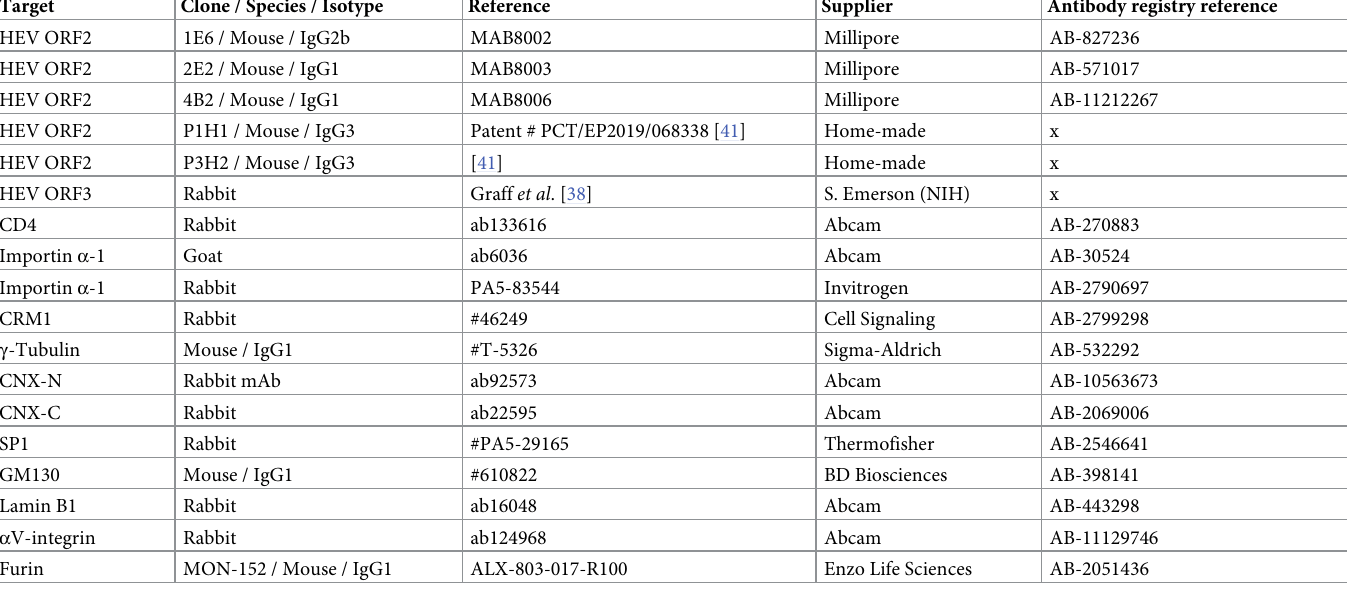
Table 1. Primary antibodies used for Western-blot, immunoprecipitation and indirect immunofluorescence experiments. Target Clone / Species /